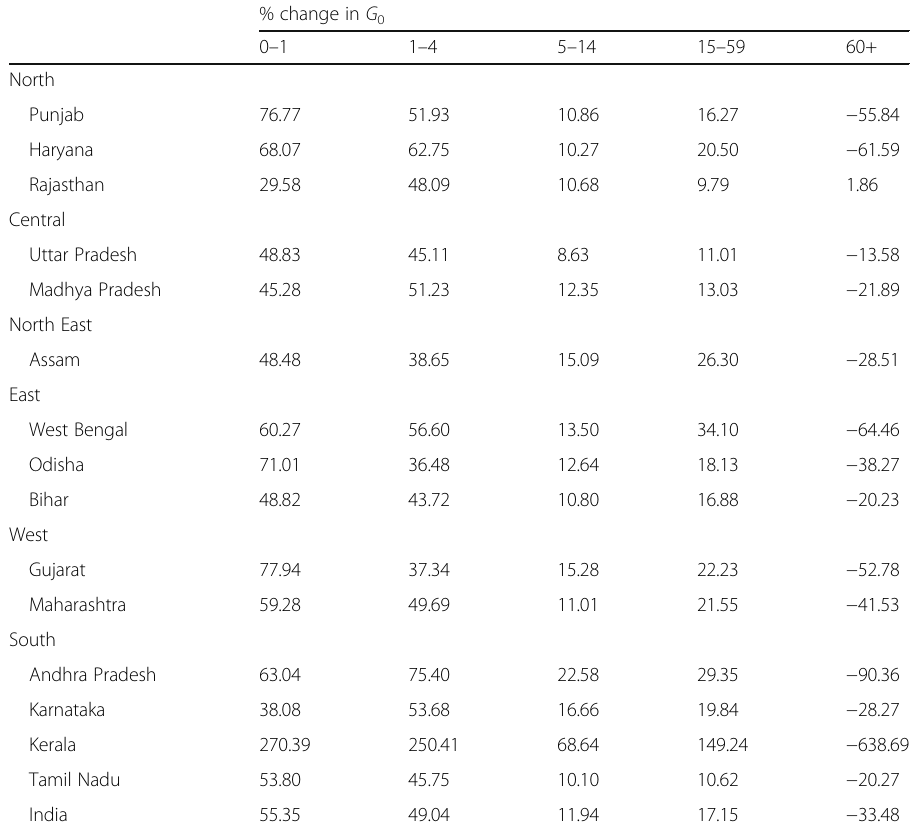
Table 4 Age-specific contributions to the decrease in Gini coefficient between 1981 and 2011, India and major states, women